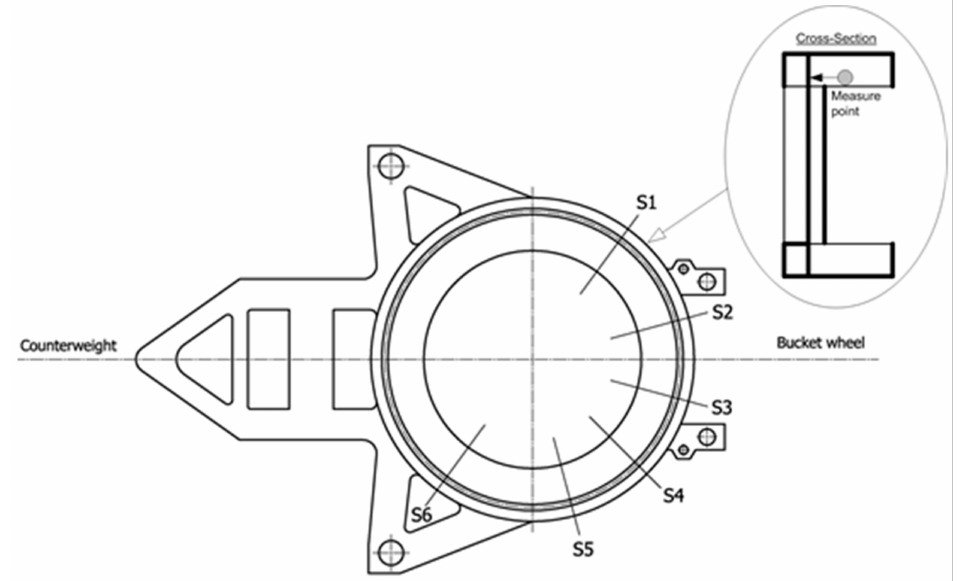
Figure 11. Distribution of measurement cross-sections in the structure of ring girders of the tested